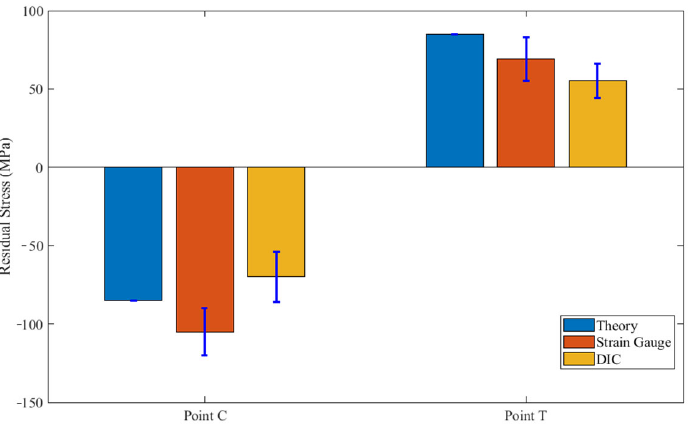
Figure 10. Comparison of the average theoretical, strain gauge and DIC estimations of residual stress at points C and T. The error bars represent the 95% confidence values of the stress.